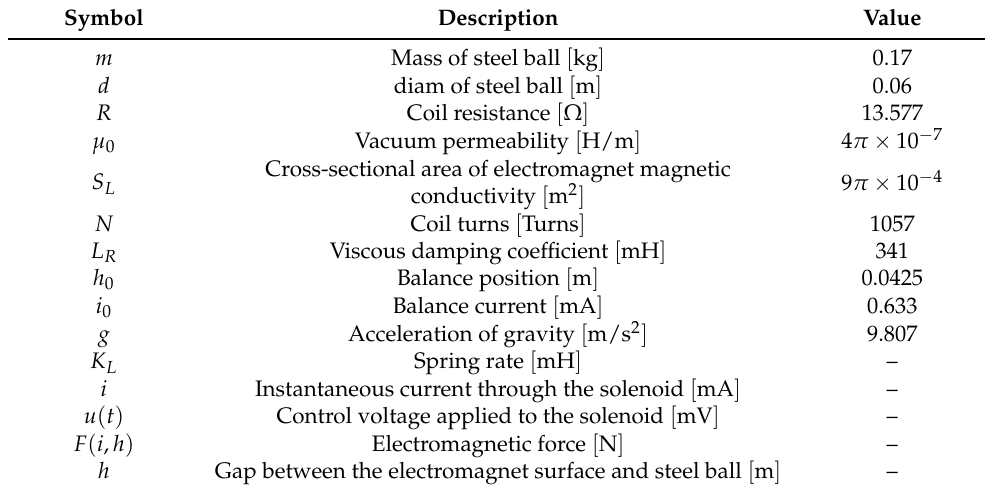
Table 1. Parameters and variables of the magnetic levitation ball